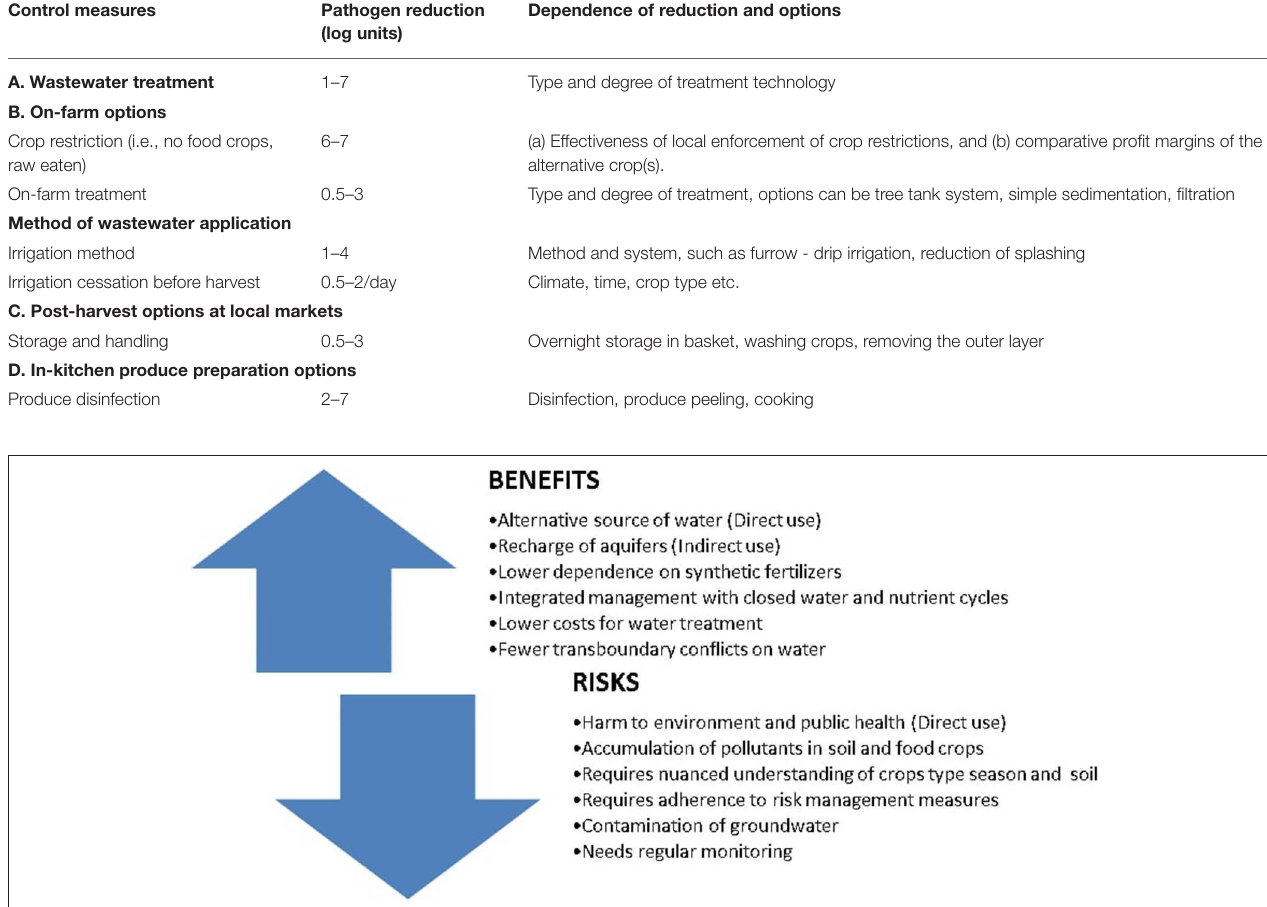
FIGURE 3 | Risks and benefits of wastewater